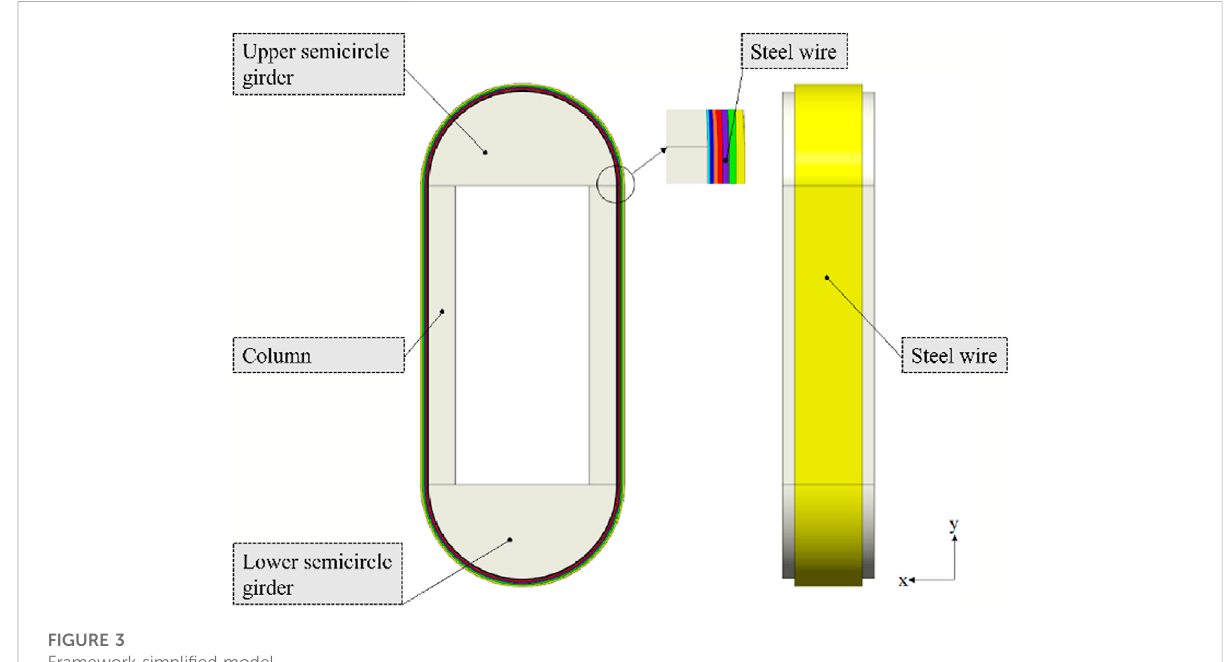
FIGURE 3 Framework simpli fi ed model.